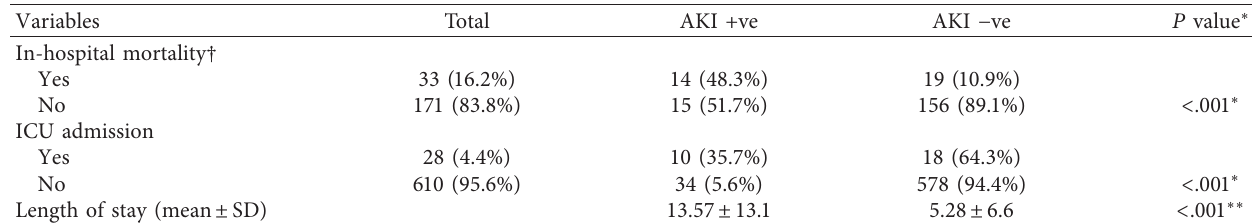
Table 3: Acute kidney injury outcomes.